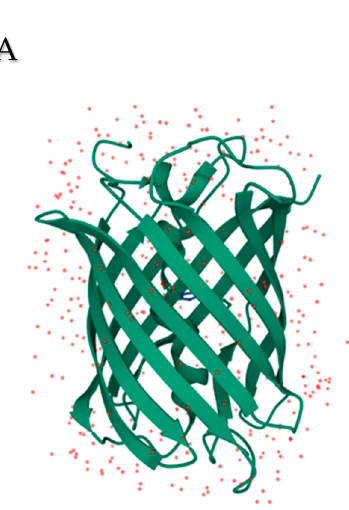
Figure 1. ( A ) Crystal structure of mCherry protein (Shu X., Remington S. J., RCSB PDB, 2006); ( B ) absorption (blue line) and emission (red line) spectra of mCherry protein and extinction spectrum of AgNWs (black line) measured in solution.